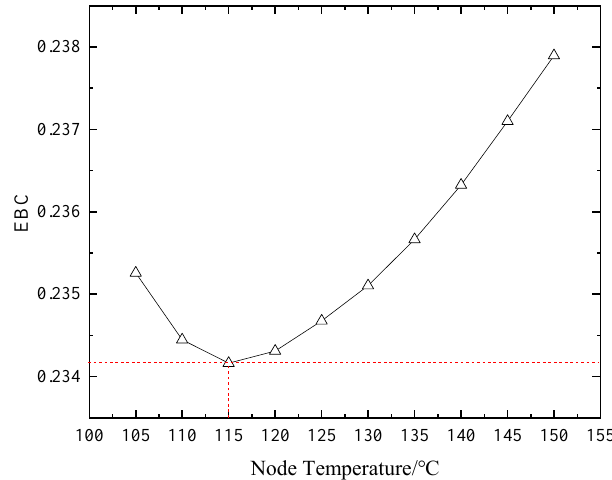
Figure 5. Relationship between the node temperature and the energy-grade balance coefficient (EBC).